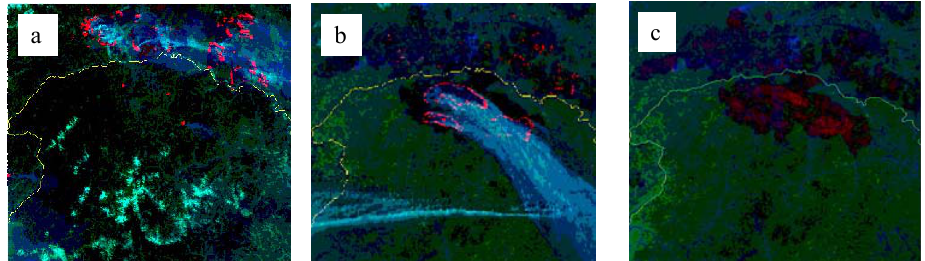
Figure 1. Daxing’anling forest fire hot-spot and burnt area detection by using NOAA/AVHRR.